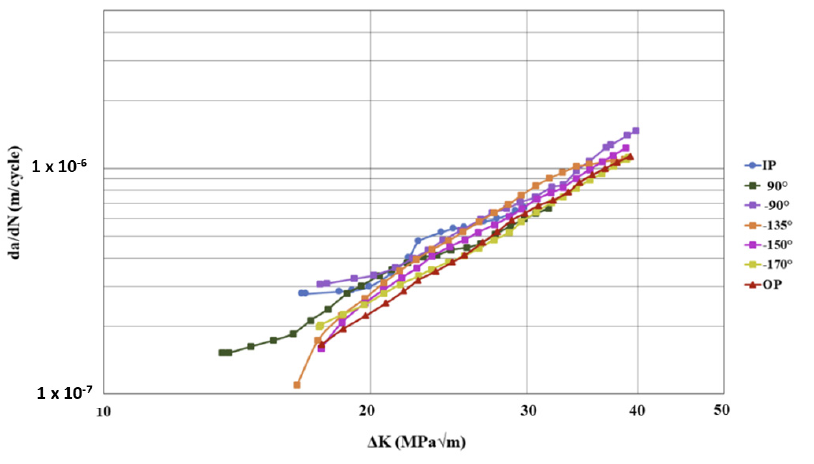
Figure 10. Paris curves comparing the effects of phase angle under TMFCG conditions on Ti-6246 with a temperature cycle of 200–500 °C, maximum stress of 500 MPa and R = 0.